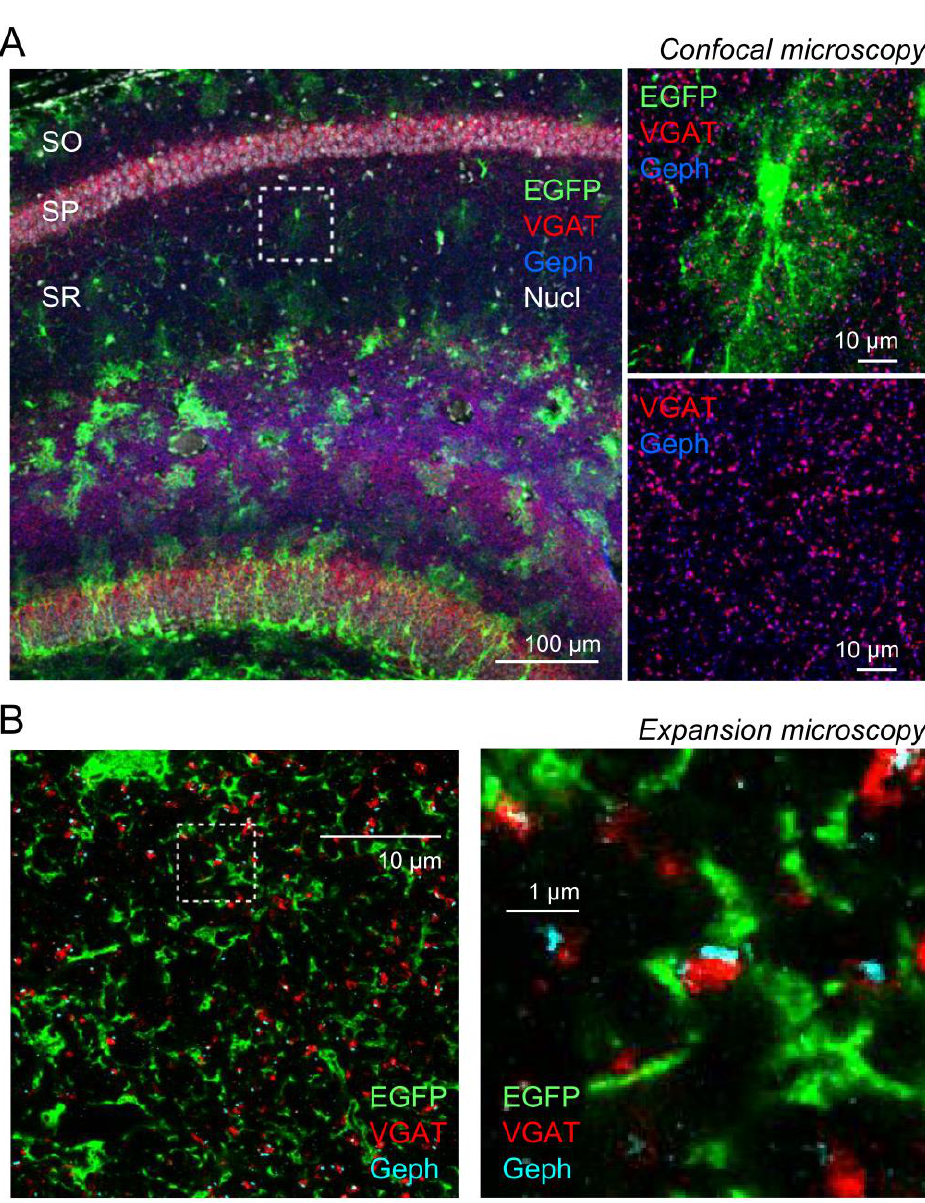
Figure 1. High-resolution visualization of GABAergic synapses and perisynaptic astrocytic pro- cesses using expansion microscopy. ( A ) Example of immunohistochemistry combining labeling of the vesicular GABA transporter (VGAT, red), the postsynaptic clustering protein gephyrin (Geph, blue), the EGFP expressed by astrocytes (green) and the nuclei (Nucl, Hoechst 33342, white). Confocal microscopy without expansion. Left panel: overview (SR: stratum radiatum , SO: stratum oriens , SP: stratum pyramidale ). Right top panel: higher magnification of subregion outlined in the left panel (without Hoechst 33342). Right bottom panel: same subregion as above but only VGAT and gephyrin. ( B ) Example of the same immunohistochemical labeling after expansion obtained using the same confocal microscope (CA1, stratum radiatum ). Left panel: overview of subsection of an astrocyte (cell body at the top border). Right panel: enlarged region outlined in the left panel. Note the sandwich-like structure of presynaptic VGAT and postsynaptic gephyrin in the center of the image.